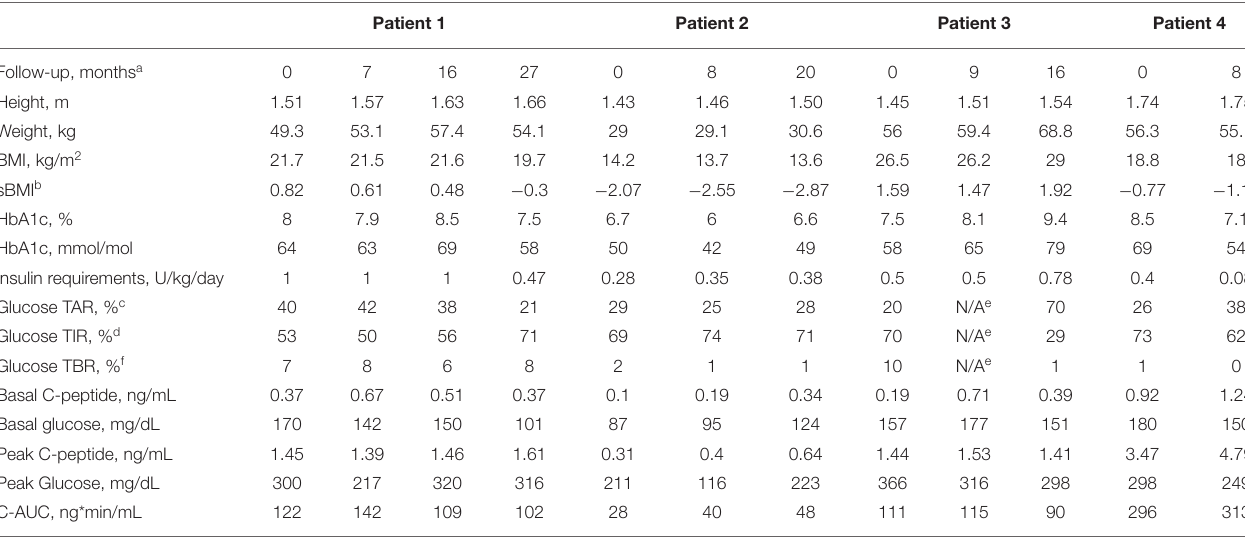
TABLE 2 | Patients’ glucometabolic